Question: Identify the chart type used in this figure.
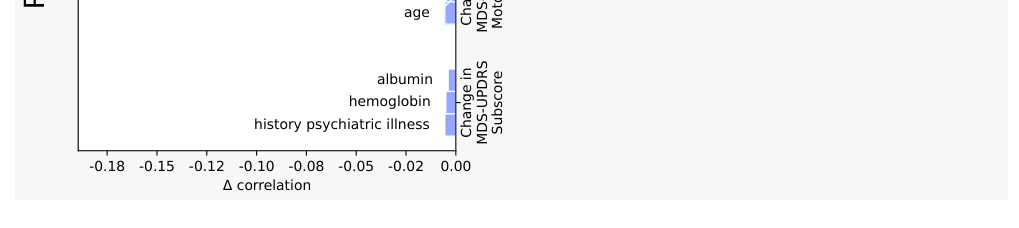
Answer: bar